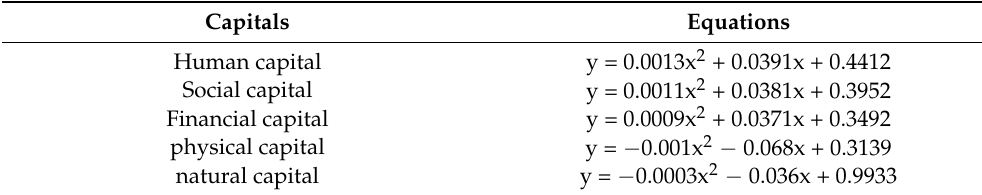
Table 3. Regression equations for each capital.